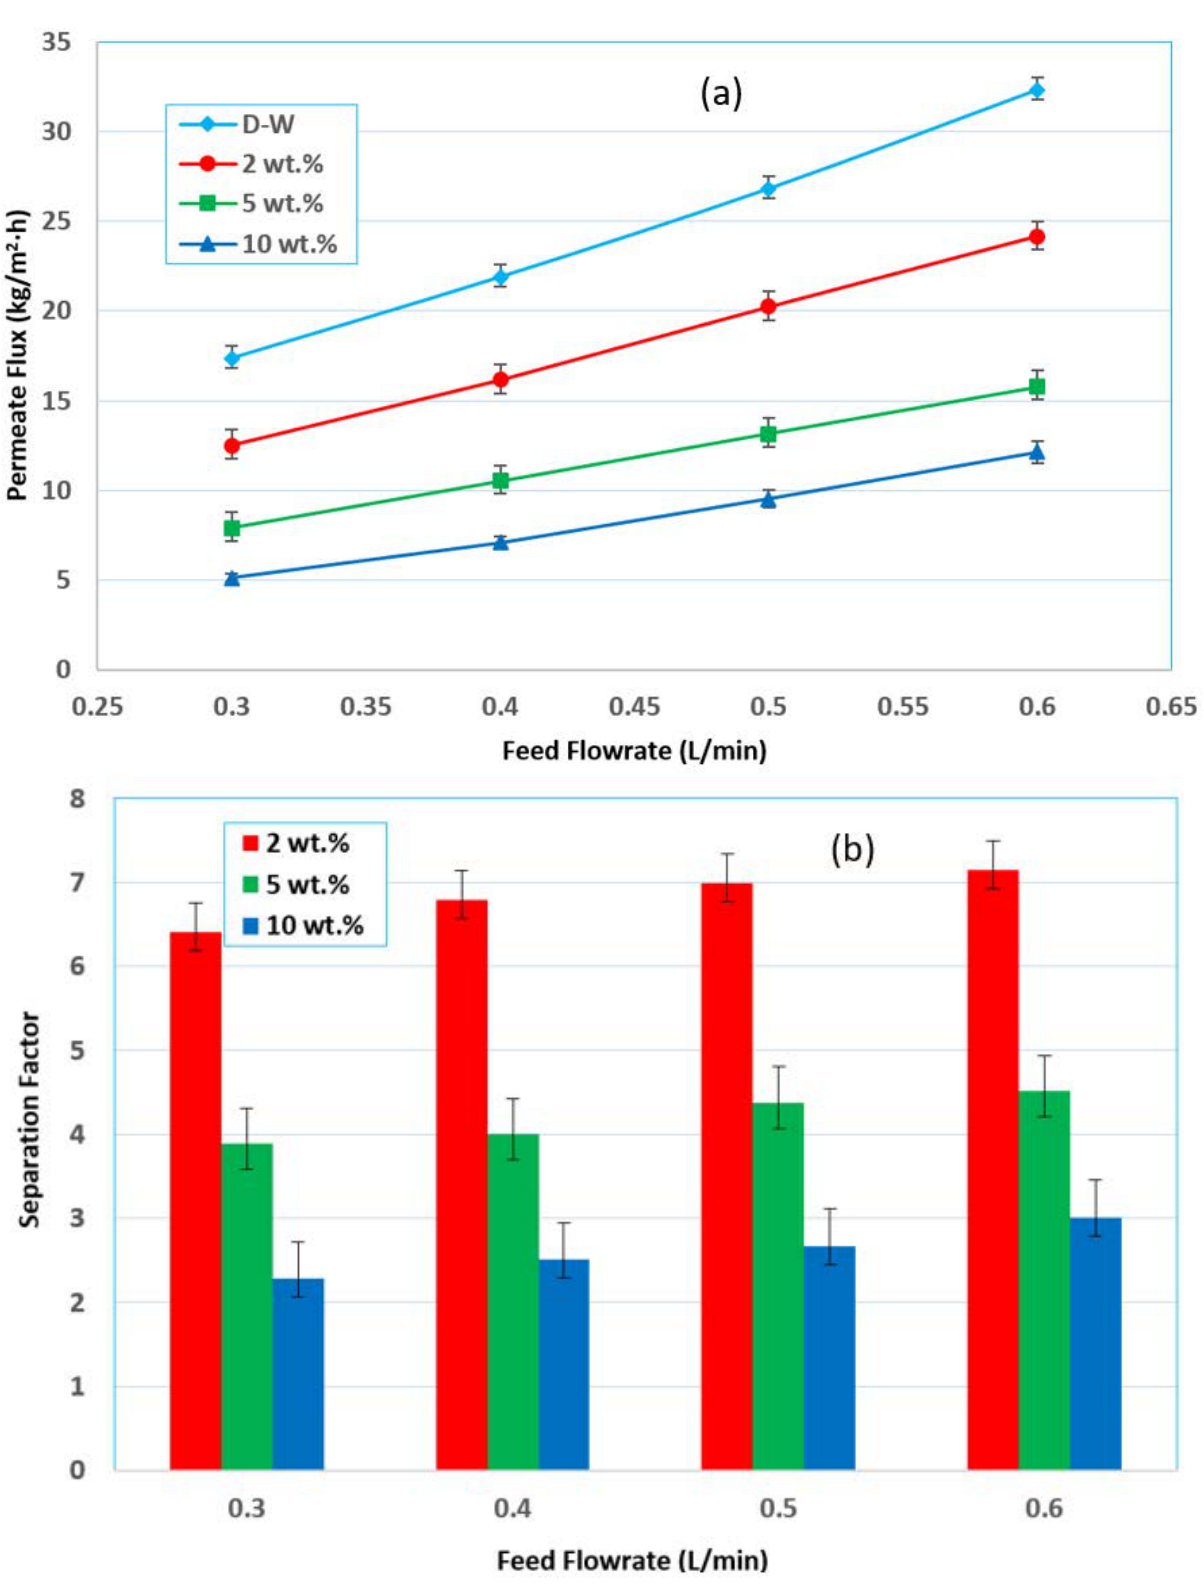
Figure 5. Effect of the feed flow rate on ( a ) the permeate flux, and ( b ) the separation factor at different concentrations of ethanol and at 30 ◦ C and 60 mmHg (abs)